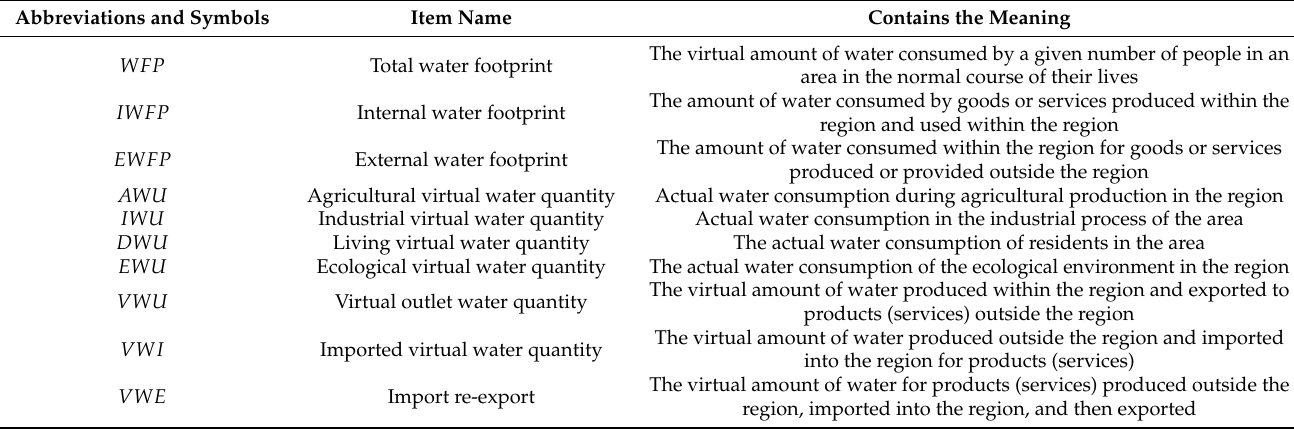
Table 2. Symbol description of water footprint model